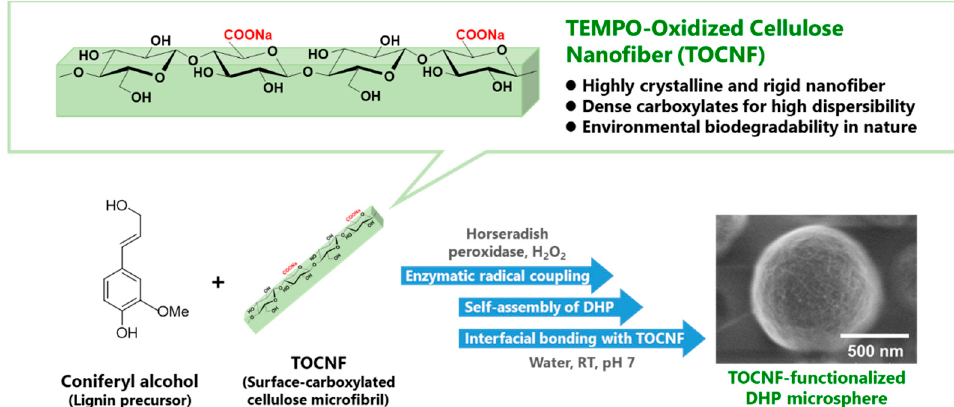
Figure 1. Schematic illustration of the research strategy: a one-pot and one-step green synthesis of spherical submicron-order TEMPO-oxidized cellulose nanofiber (TOCNF)-functionalized dehydrogenative polymer (DHP) microparticles.